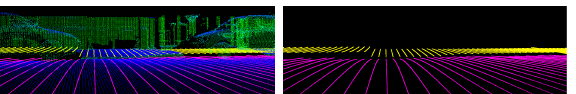
Figure 17: Surface model of a street. Point cloud is superimpose on the